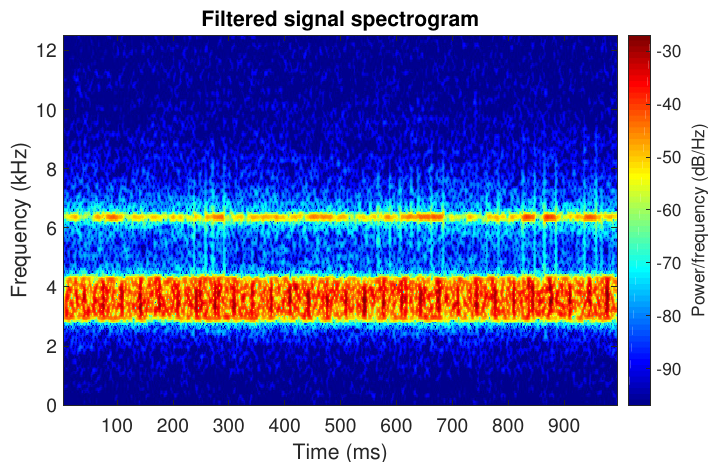
Figure 19. Spectrogram of filtered signal s 2 by Spearman selector.